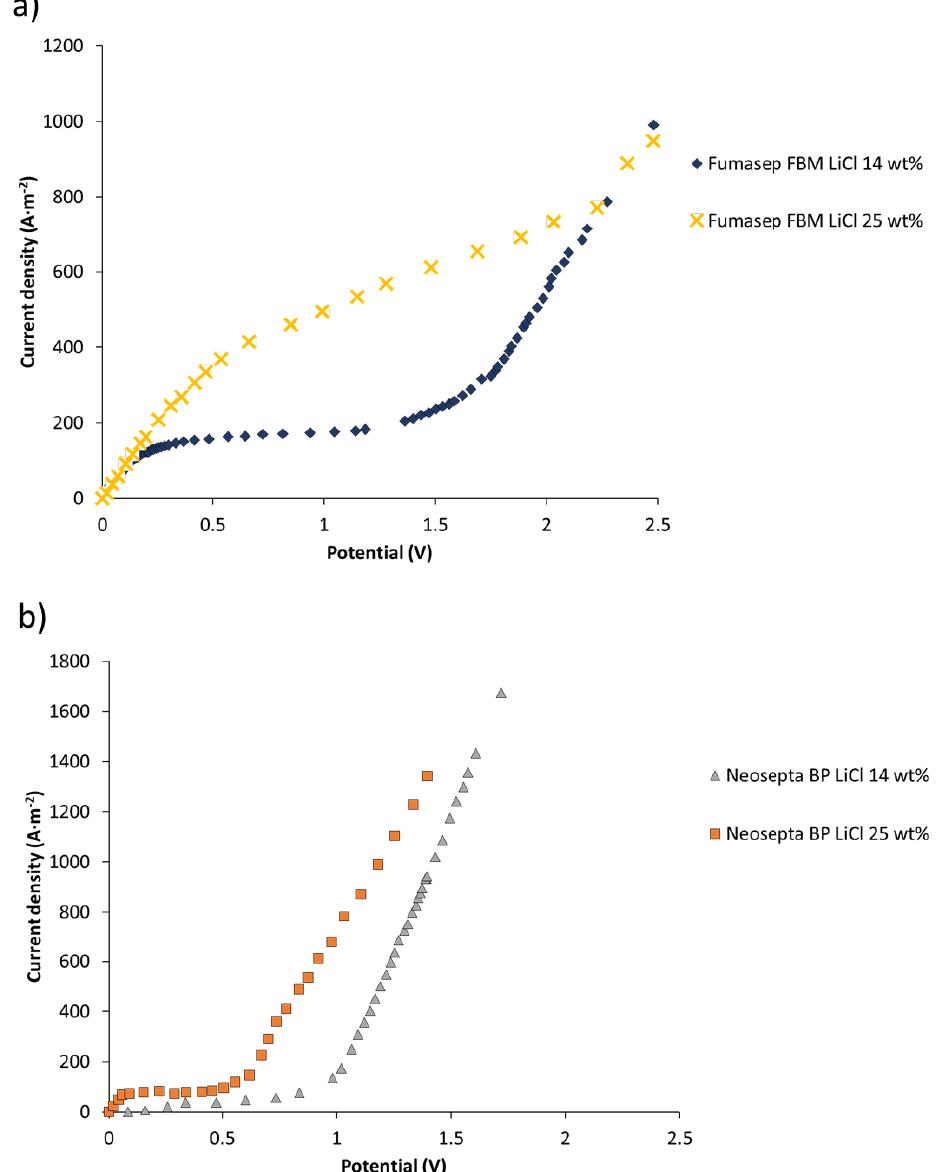
Figure 7. Salt leakage current – potential curves in bipolar membranes: ( a ) Fumasep FBM; ( b ) Neosepta BP.